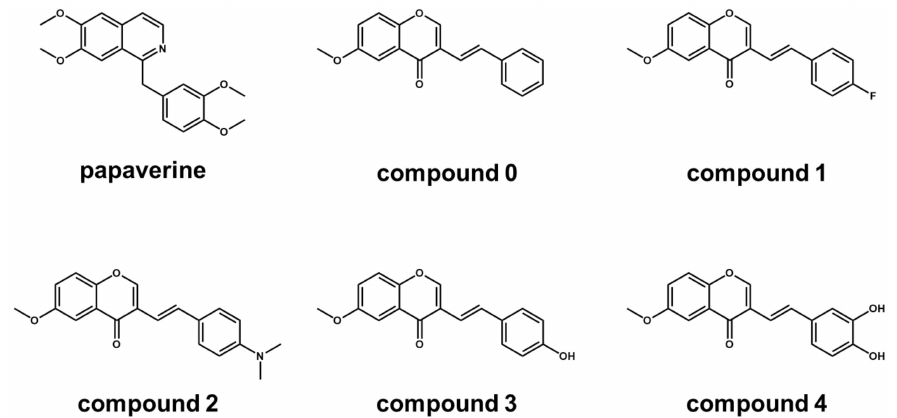
Figure 2. Structures of papaverine and five 6M3SC